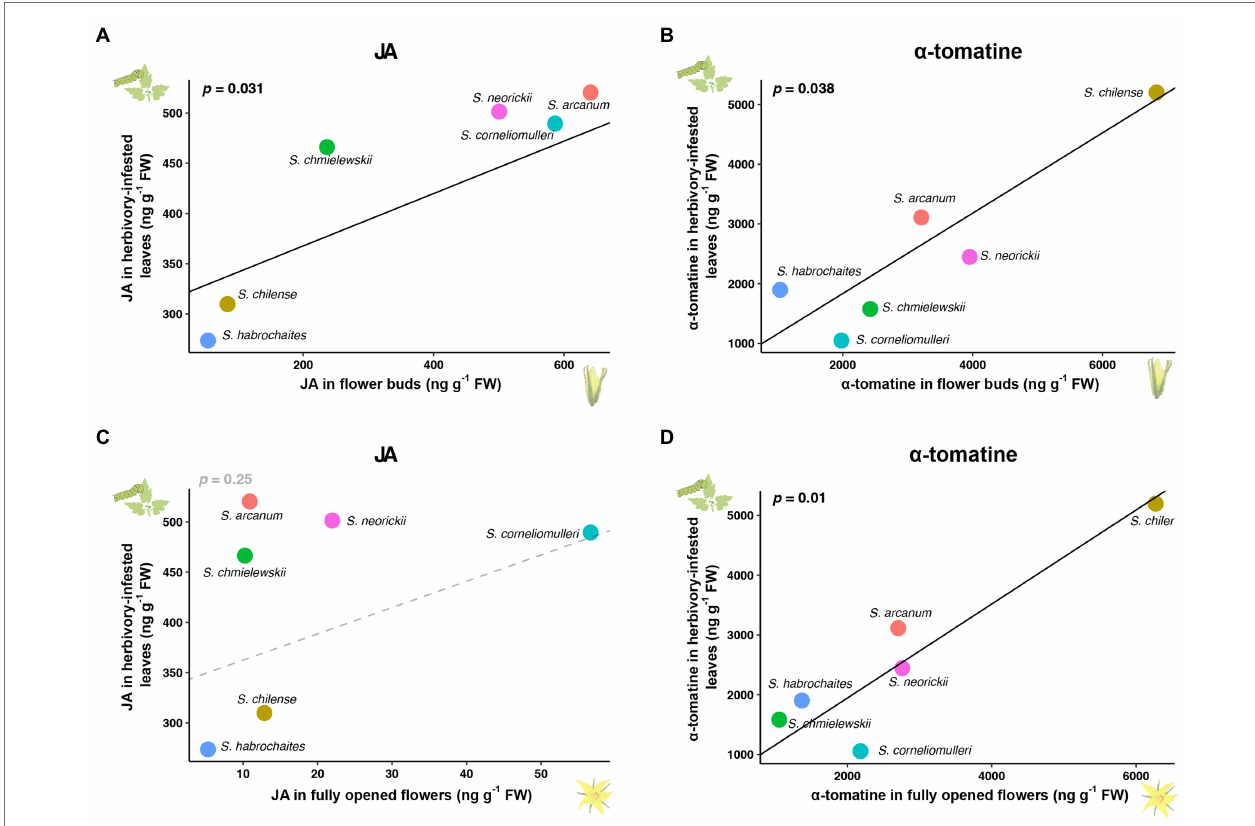
FIGURE 5 | Diffuse coevolution of JA and α -tomatine in tomato leaves and flowers. (A,C) Correlated changes of JA between herbivory-infested leaves and flower buds (A) or fully opened flowers (C) among six wild tomato species. (B,D) Correlated changes of α -tomatine between herbivory-infested leaves and flower buds (B) or fully opened flowers (D) among six wild tomato species. Considering the phylogenetic relationship, correlated variations were analysed using a generalised least squares method with a phylogenetic tree based on the phylogeny of Solanum sect. Lycopersicon from Pease et al.